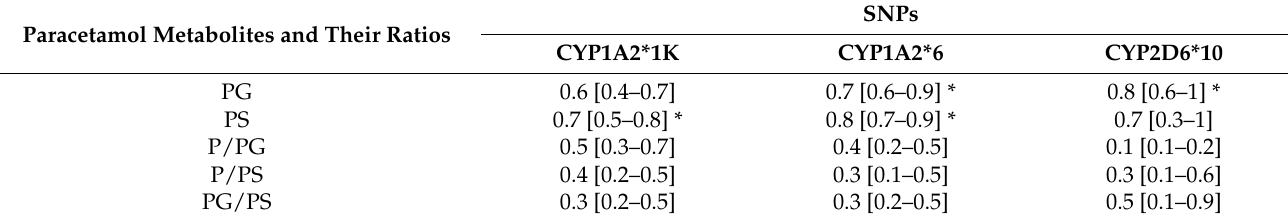
Table 3. Diagnostic accuracies as indicated by AUCs (95% CI) of paracetamol metabolites and their ratios with